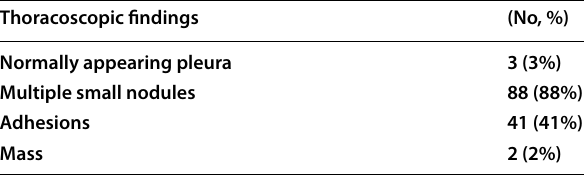
Table 3 Thoracoscopic findings among studied patients Thoracoscopic findings